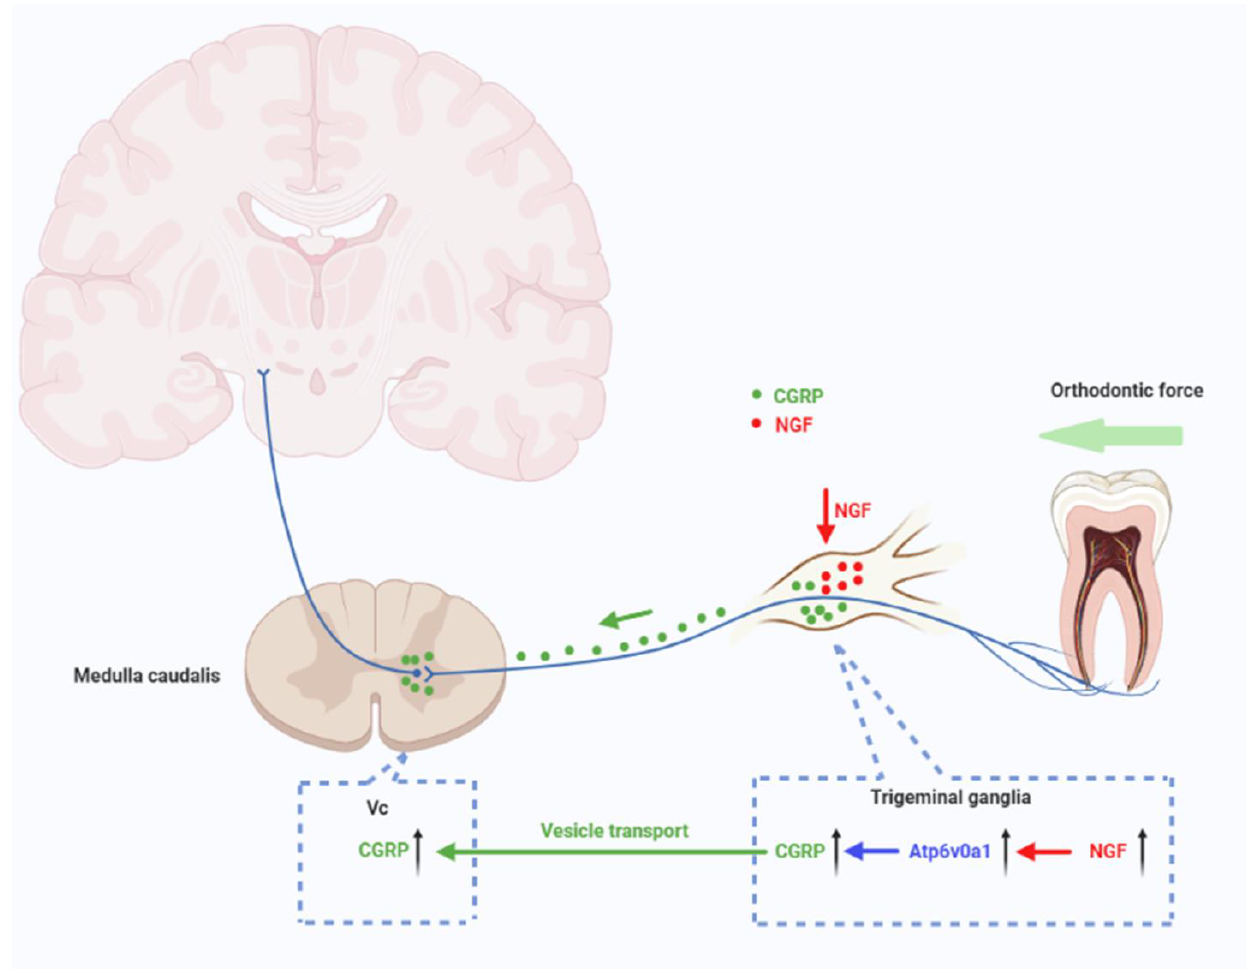
Figure 7. A schematic illustration depicting the mechanisms of NGF-induced upregulation of CGRP in orofacial pain induced by experimental tooth movement. The intraganglionic administration of NGF stimulates the upregulation of CGRP in TG is independent on Atp6v0a1, and the upregulation of CGRP in Vc is dependent on vesicle transport.